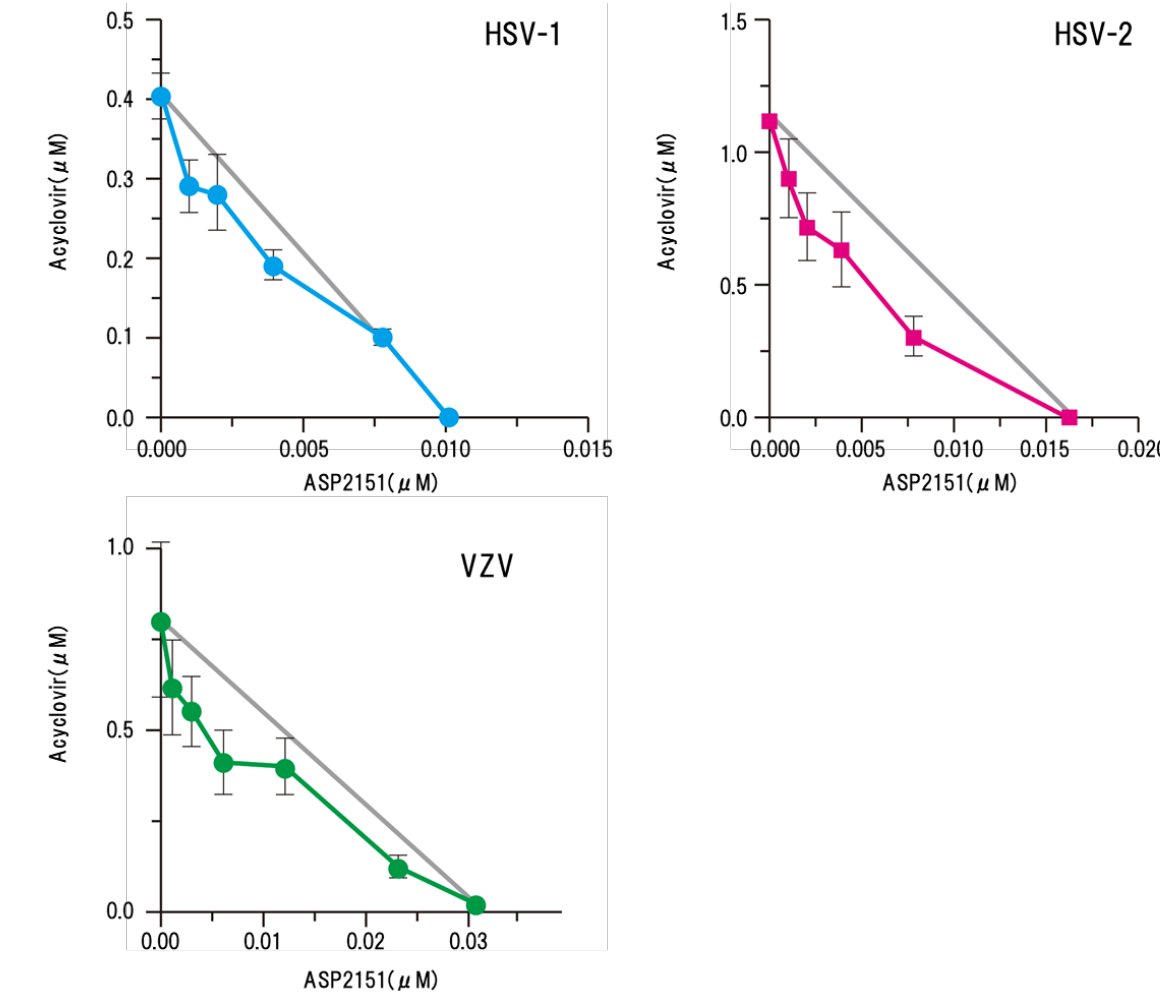
Figure 6. Synergism of amenamevir (ASP2151) with acyclovir against HSV-1, HSV-2, and VZV [15]. Synergism of amenamevir with acyclovir was analyzed by isobologram, and the solid straight line (gray) indicates the theoretical additive antiviral activity in combination with amenamevir and acyclovir. Each point (EC 50 ) is the mean ± standard error from four independent experiments. Significant synergism was observed for the combination of amenamevir and acyclovir ( p = 0.0005), and low concentrations of amenamevir showed stronger synergism with acyclovir than the higher concentrations of amenamevir. The authors obtained permission from Antiviral Research to reuse these figures [15].